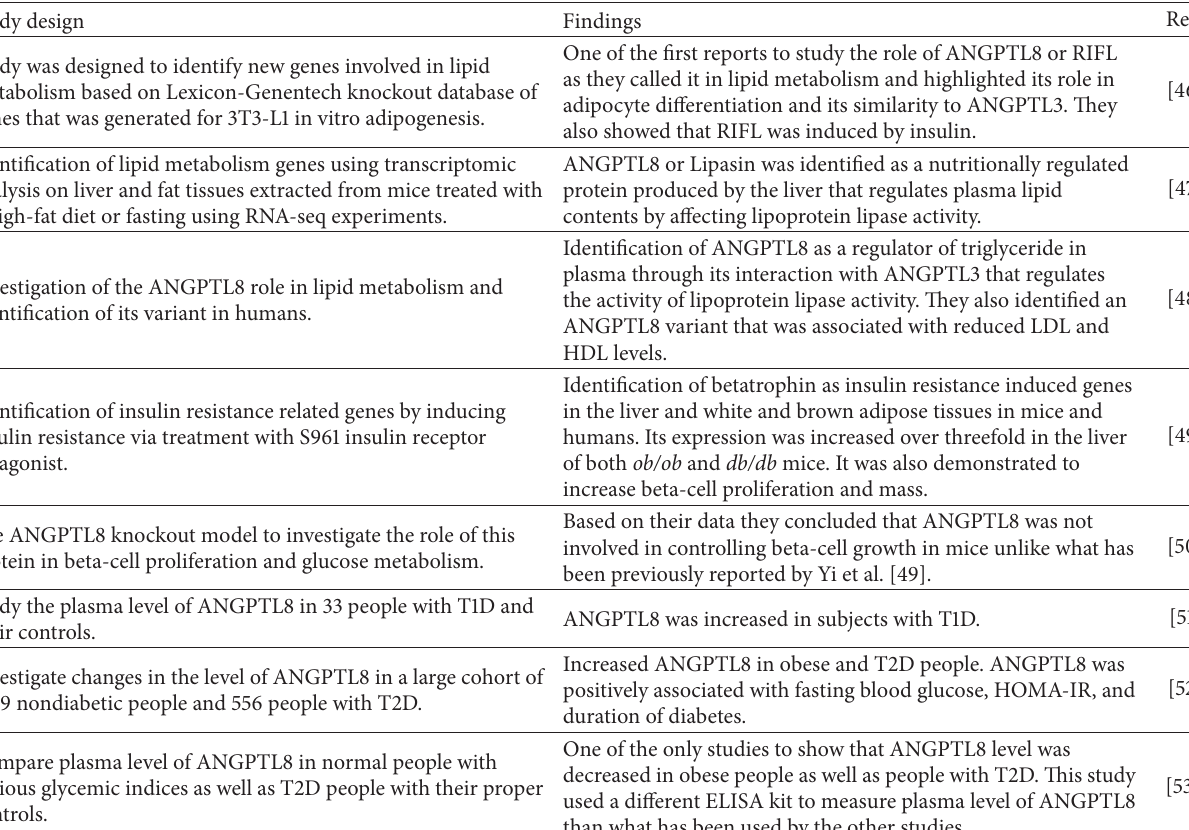
Table 1: Selected early studies investigating the role of ANGPTL8 in obesity and